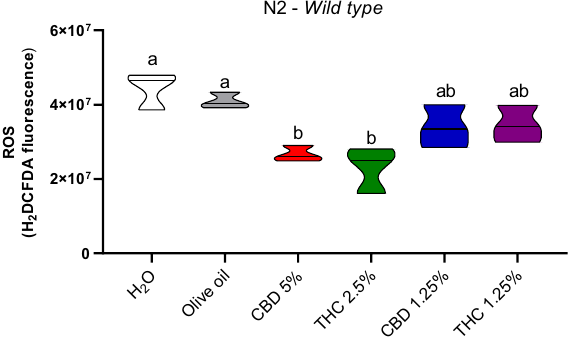
Figure 3. Reactive oxygen species (ROS) identification (H 2 DCFDA) in C. elegans wild-type strain (N2). Data are expressed by the mean ± standard error (SEM). Means followed by the same letter are not significantly different according to Tukey’s test ( p > 0.05).